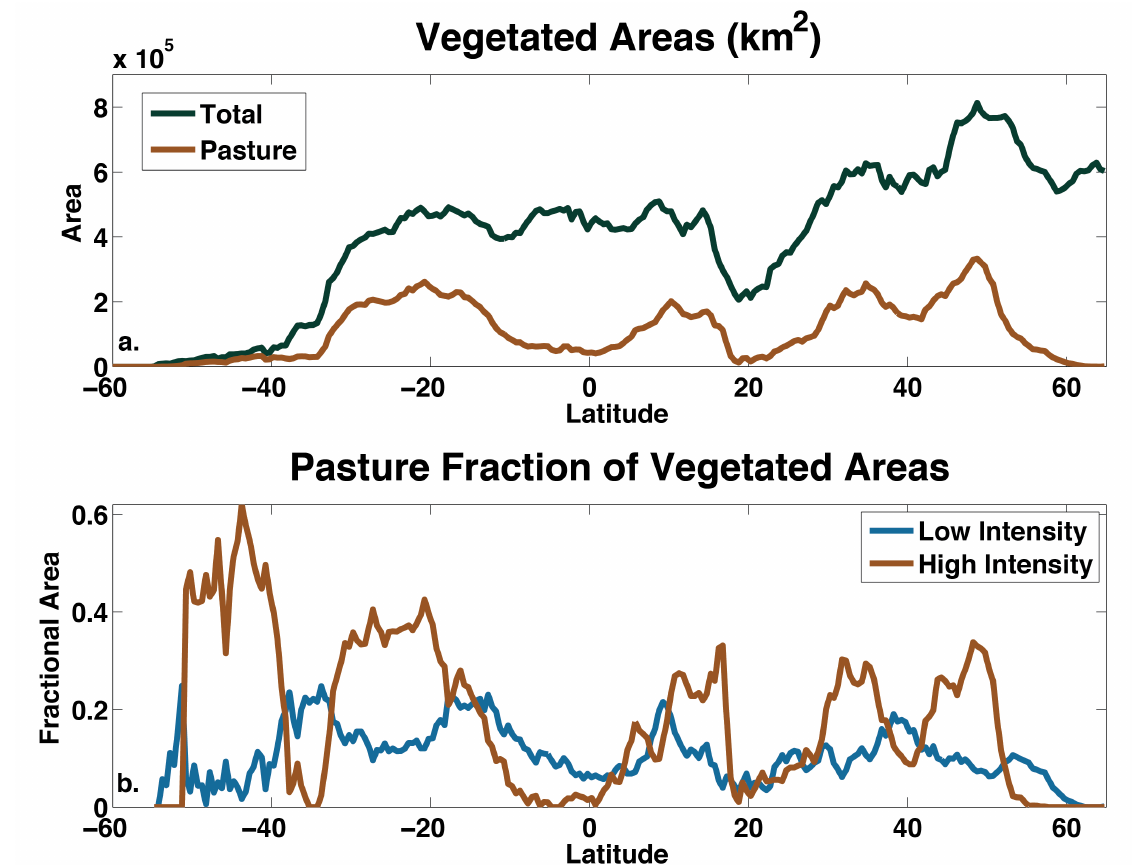
Figure 3. Latitudinal distribution of pasture areas from the HYDE3.1 dataset: ( a ) total vegetated and pasture areas (km 2 ) and ( b ) fraction of vegetated areas covered by low intensity ( ≥ 10% to ≤ 50% percent cover) and high intensity pasture ( > 50% percent